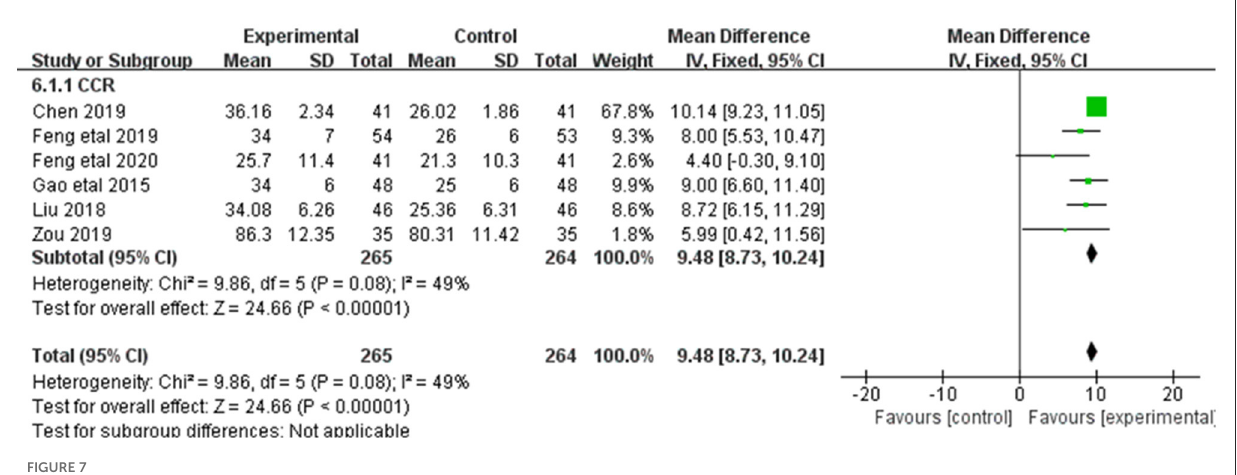
FIGURE7 Forest plot of analysis of the Ccr of